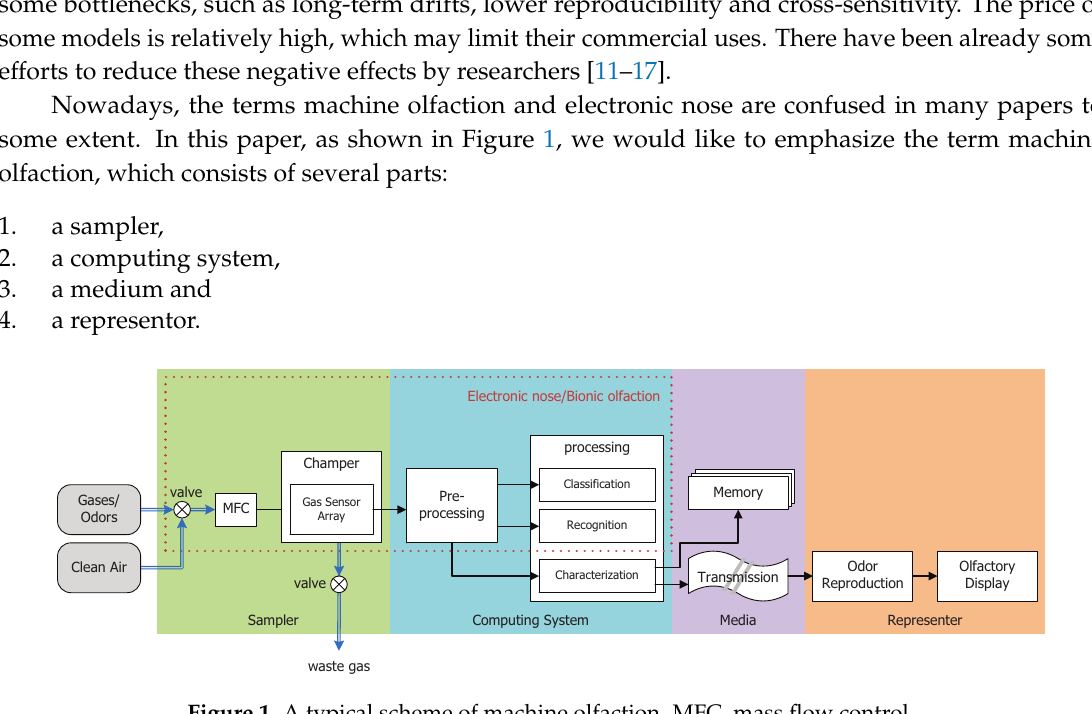
Figure 1. A typical scheme of machine olfaction. MFC, mass flow